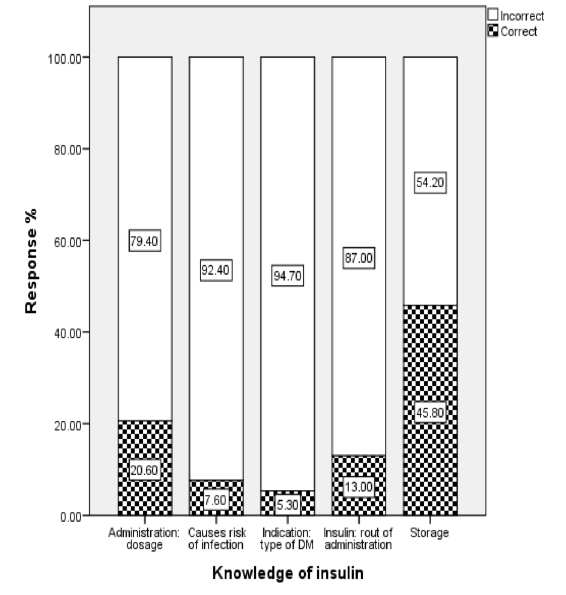
Figure 2C and 2DPharmacological treatment of diabetes.